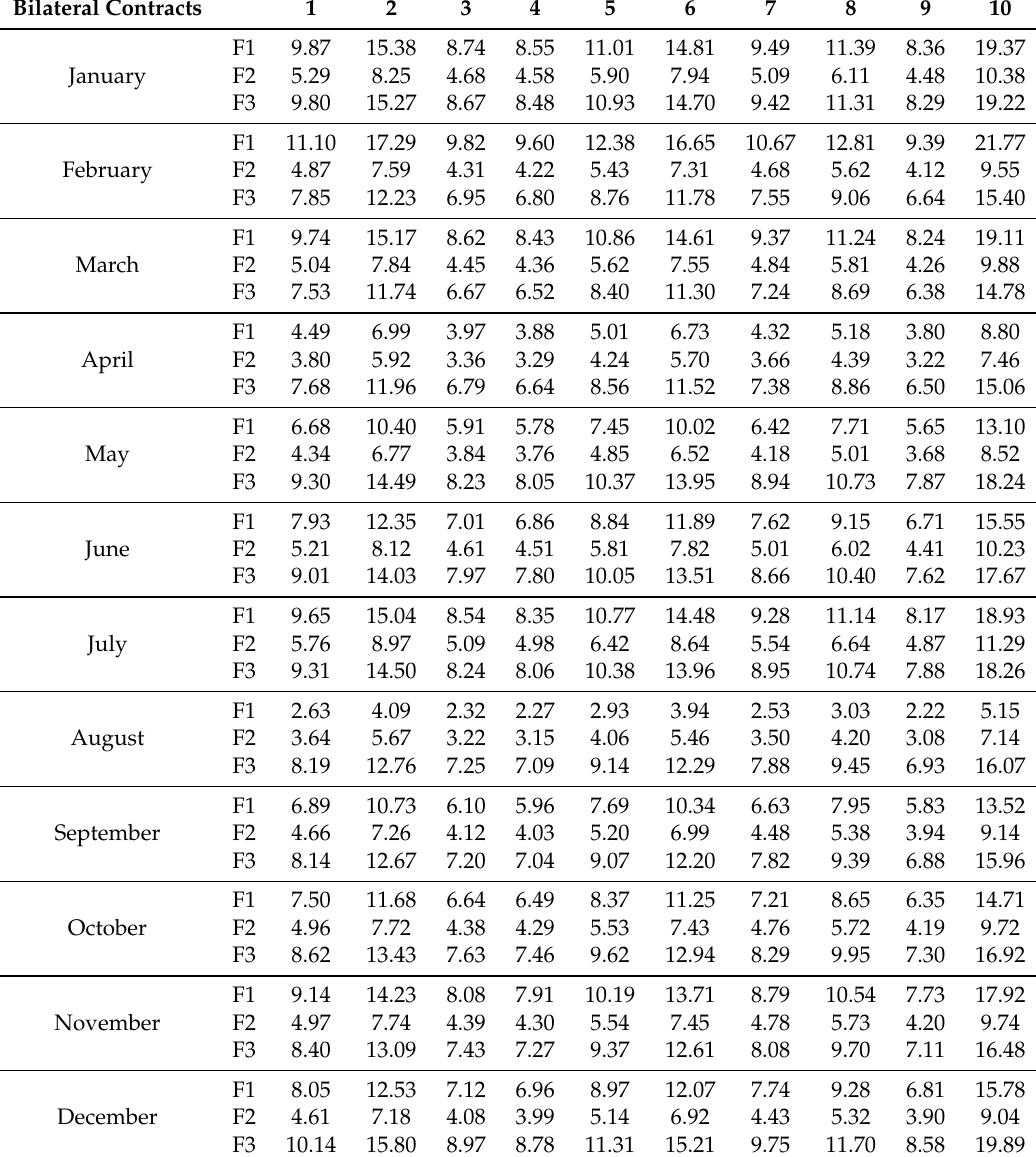
Table A3. Bilateral contracts lower bounds (MWh).